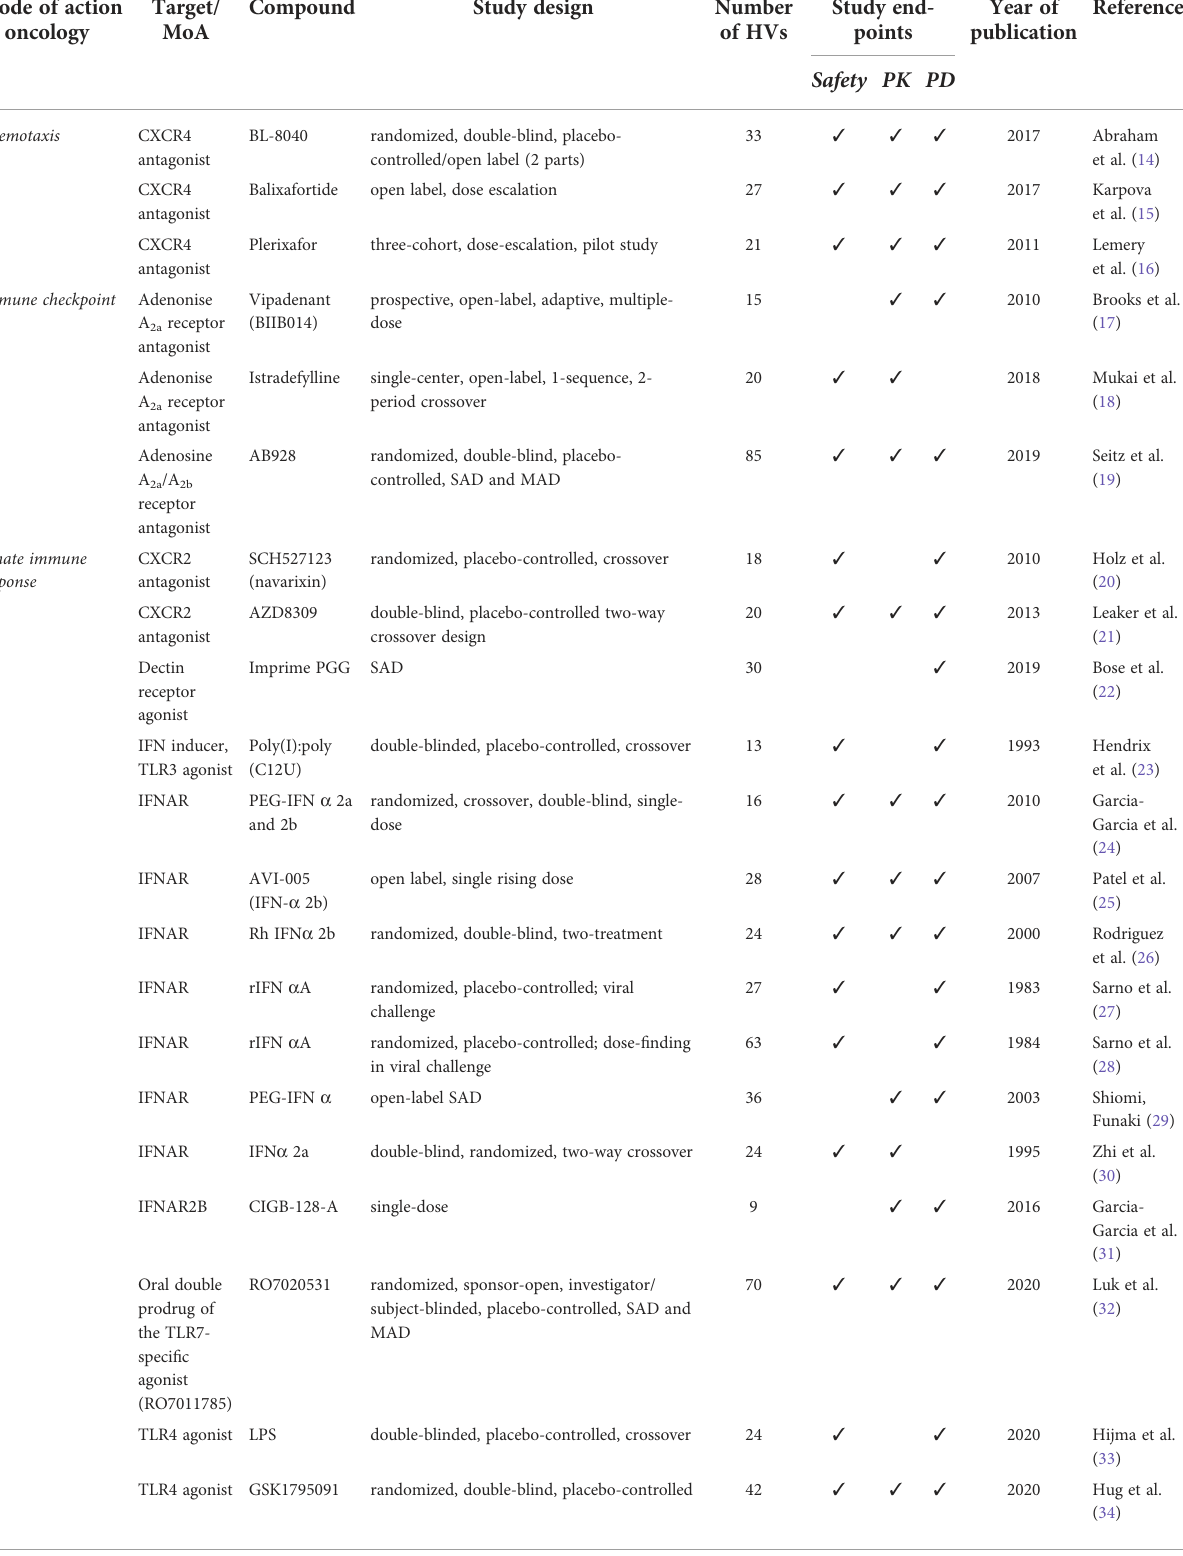
TABLE 2 Overview of the included clinical studies conducted in healthy volunteers (HVs) with a compound possibly relevant for immuno- oncology, with their corresponding study design and study endpoints, grouped by potential mode of action in